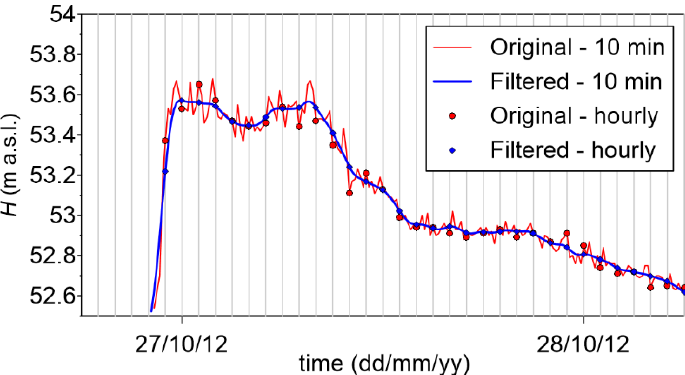
Figure 4. Example of filtering of recorded levels at Ponte Verdi.